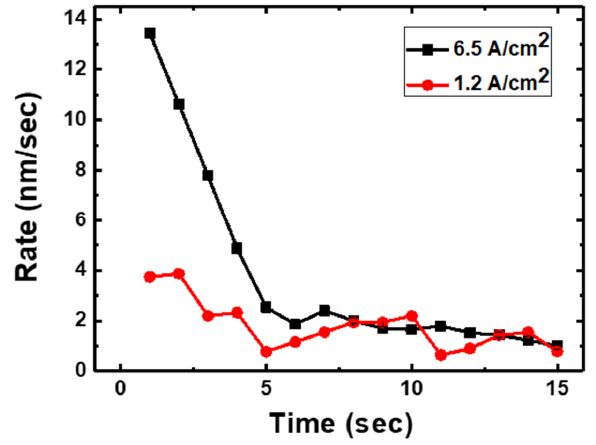
Figure 4. Growth rates of the spinel blocks with different electron beam doses.